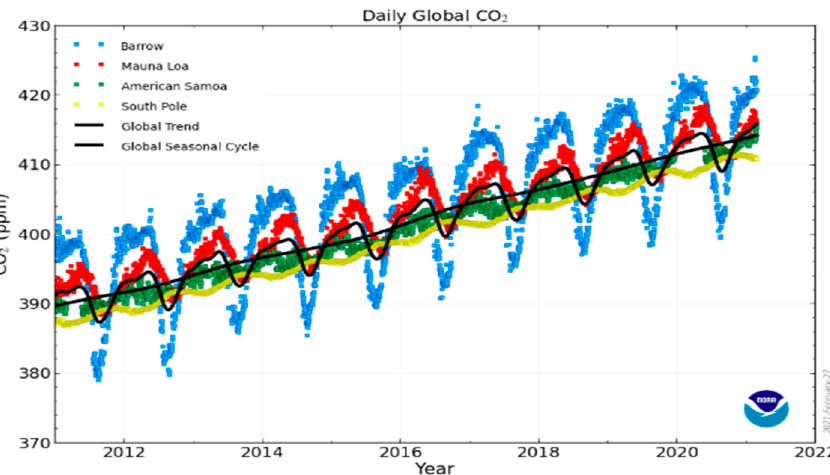
Figure 1. Daily global CO 2 . Shows daily averaged CO 2 from four GML Baseline observatories; Barrow, Alaska (in blue); Mauna Loa, Hawaii (in red); American Samoa (in green); and South Pole, Antarctica (in yellow). The thick black lines represent the average of the smoothed seasonal curves and the smoothed, de-seasonalized curves for each of the records. These lines are a very good estimate of the global average levels of CO 2 . Source: [62]. (Available online: https://www.esrl.noaa.gov/gmd/ccgg/trends/gl_trend.html. accessed on 1 April 2021.)